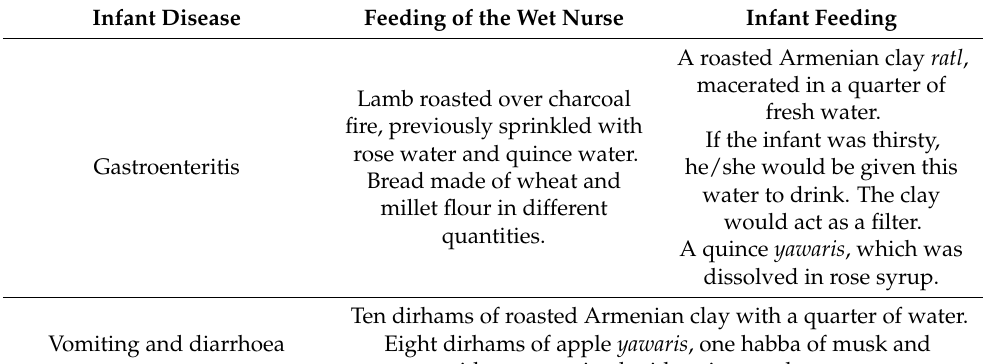
Table 2. Common diseases of the infant. Dietary recommendations for the wet nurse and infant. Infant Disease Feeding of the Wet Nurse Infant Feeding